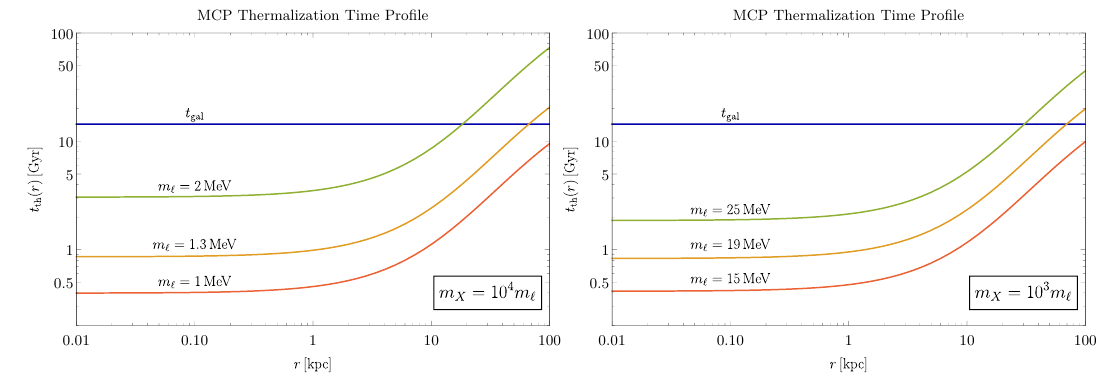
Figure 7 . The thermalization time of the X and ‘ plasmas as a function of the radius, with t gal for comparison. t th was computed in section 4.1 using the isothermal halo density in eq. (A.3).